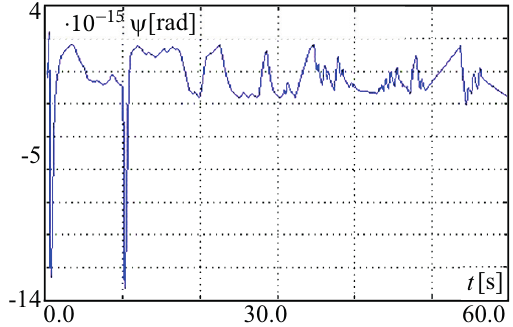
Fig. 11. Displacement along the OY -axis